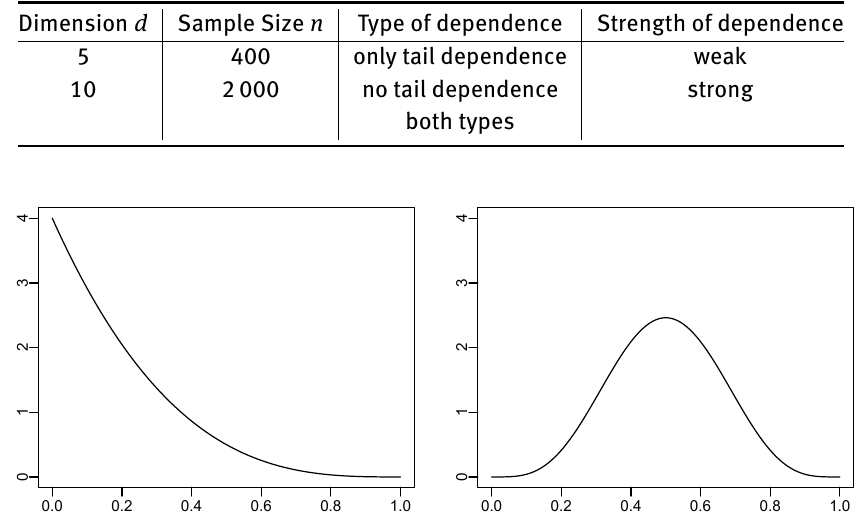
Table 1: List of factors that determine the set of simulation scenarios.